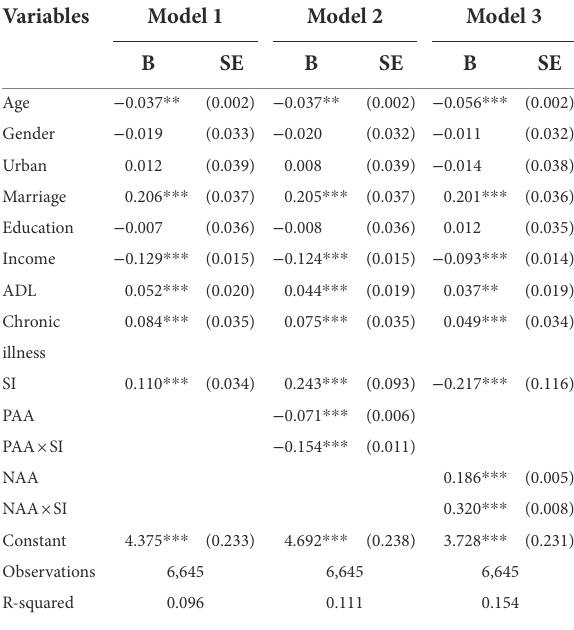
TABLE 3 Test results of mediating effect